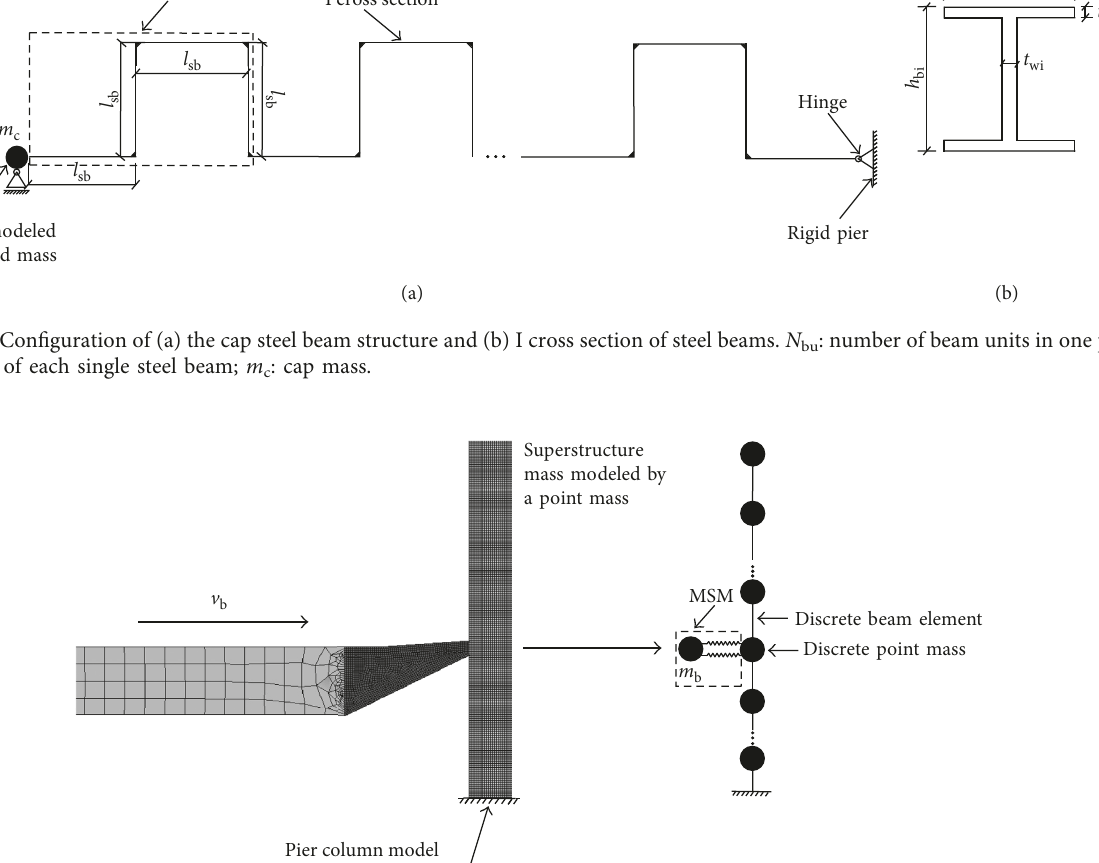
Figure 3: Transformation of FBIM (left) into CMM